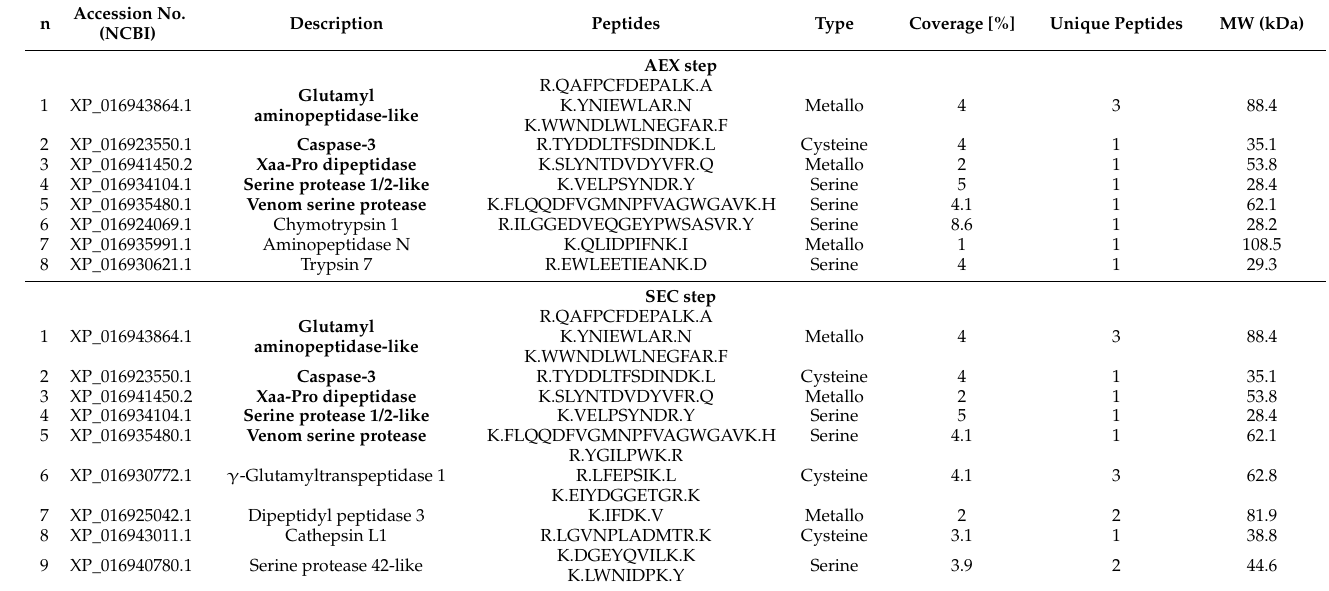
Table 2. Peptidases from the D. suzukii larvae identified following the AEX and SEC purification steps (entries in bold were identified after both steps). The identification score is represented in terms of the percent coverage and unique peptides. The identified enzymes and their peptides detected by LC-MS/MS are related to the NCBI accession number. The catalysis type and molecular masses are provided for each enzyme based on the NCBI